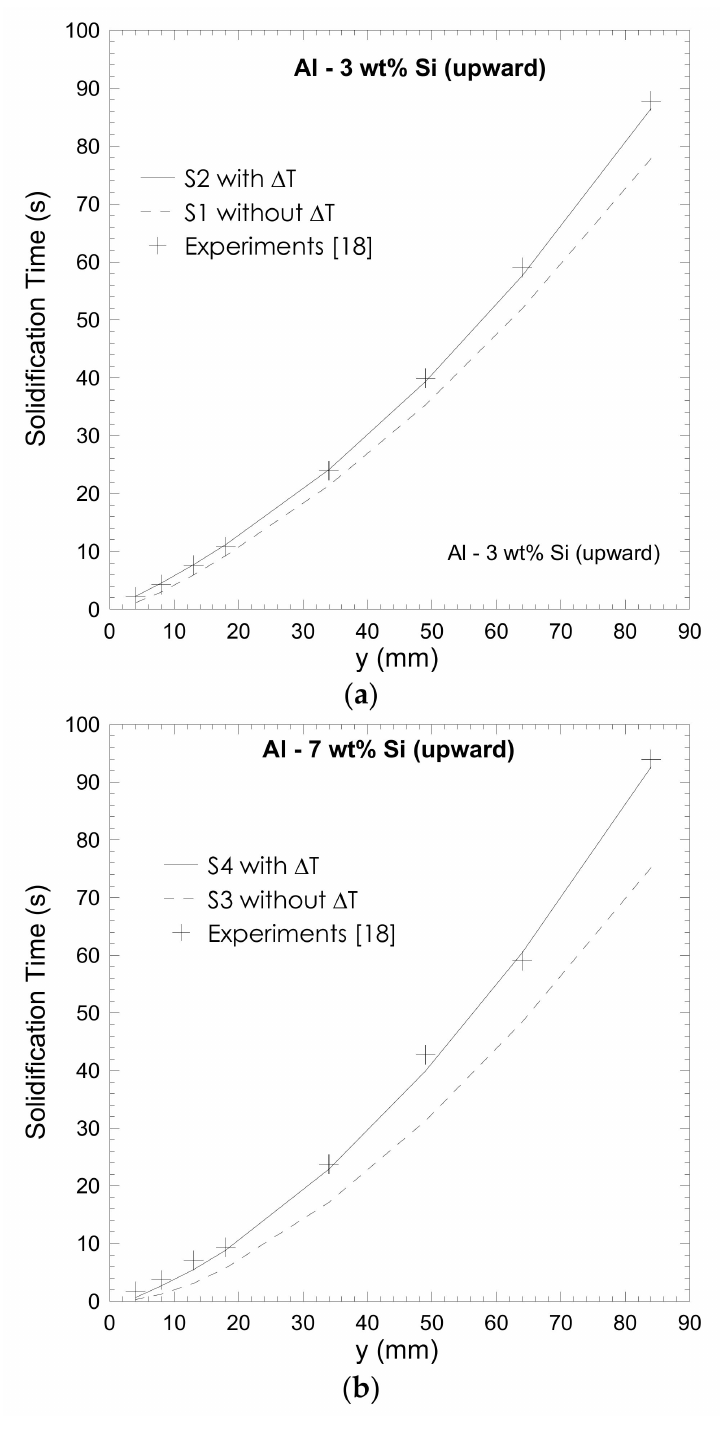
Figure 8. Experimental validation of liquid/mushy zone interface locations in simulations S2 and S4 (upward solidification); also shown is the importance of incorporating undercooling, ∆ T for valid simulations; ( a ) simulations S2 and S1, and ( b ) simulations S4 and